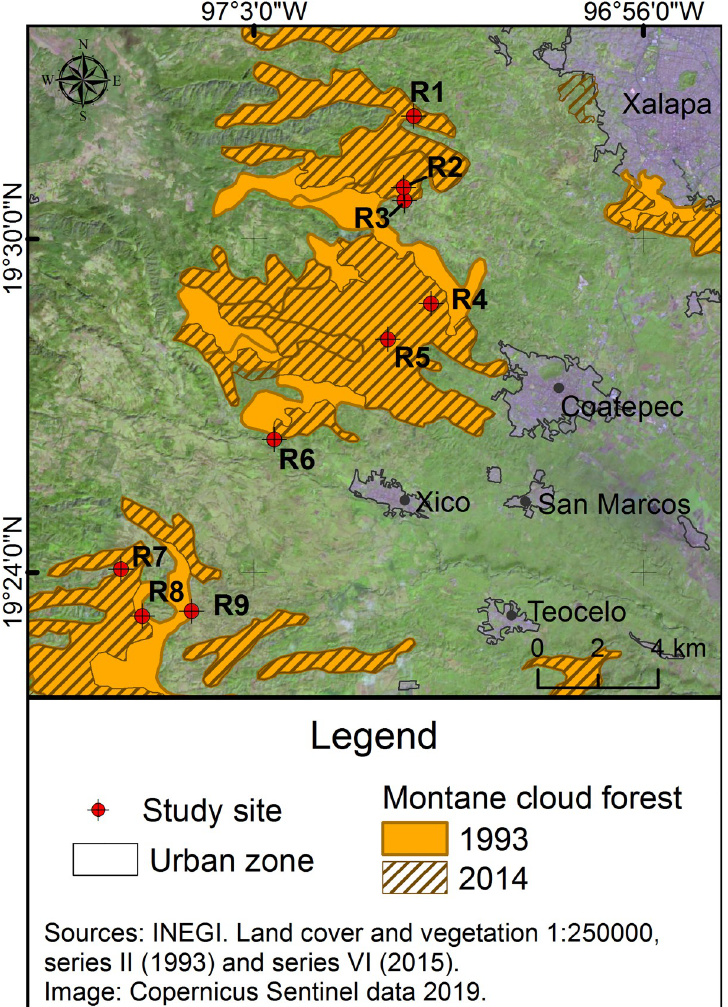
Fig 1. Location of the nine riparian remnants studied. Distribution of the nine riparian remnants of cloud forest throughout “La Antigua” Basin, in Central Veracruz (Mexico). In addition, the map also shows the change in cloud forest coverage between 1993 and 2004 in the